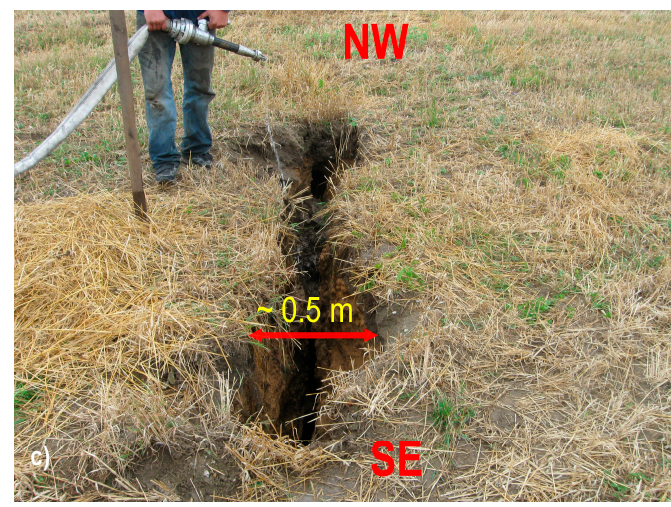
Figure 6. General view of the deformation: ( a ) SE–NW view of the damages, ( b ) NW–SE view of the damages, and ( c ) damaged surface.